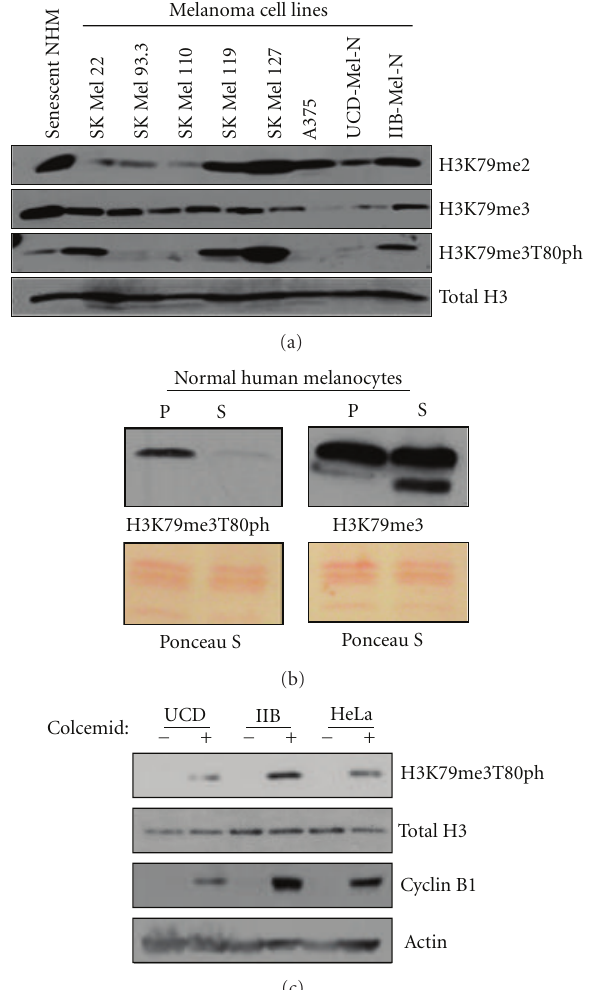
Figure 2: H3K79me3T80ph is cell cycle regulated. (a) H3K79me2, H3K79me3, and H3K79me3T80ph western blots of histones iso- lated from nondividing senescent human melanocytes and various human melanoma cell lines. (b) Western blot comparison of H3K79me3 and H3K79me3T80ph levels on histones from prolifer- ating (P) and senescent (S) normal human melanocytes. (c) UCD- Mel-N, IIB-Mel-N, and HeLa cells were either asynchronous ( − ) or mitotically synchronized using colcemid (+). Histones were isolated to perform an H3K79me3T80ph western blot, and whole cell lysate was used to perform Cyclin B1 western blotting as a control for cell